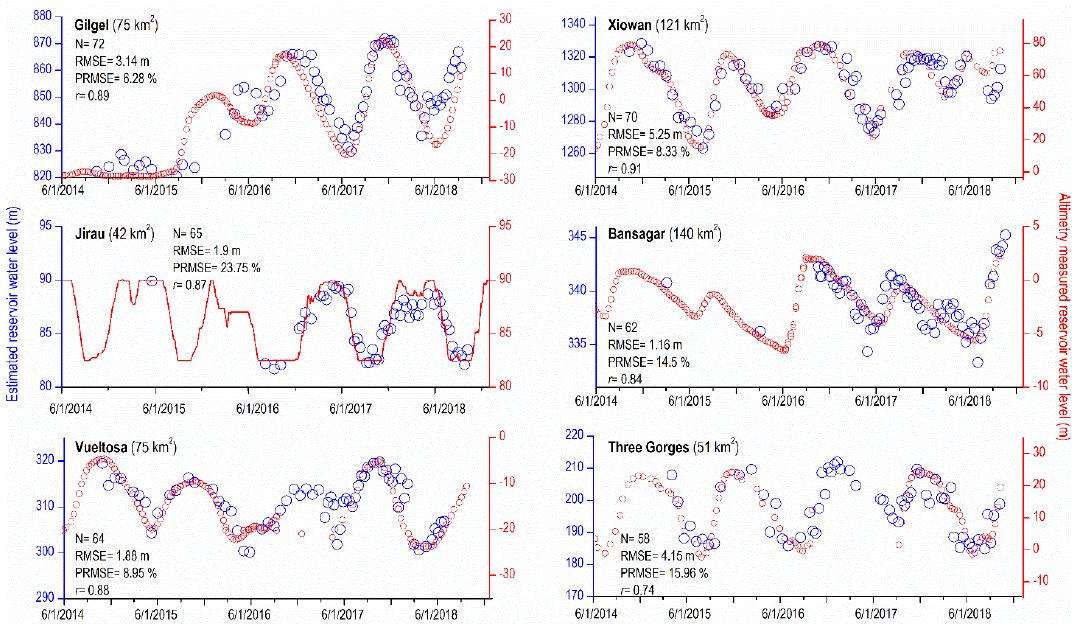
Figure 4. Six reservoir water levels (WL) (June 2014–October 2018) estimated in this study (blue) compared to reference altimetry series (red). Altimetry baseline has been adjusted to match the SRTM baseline. RMSE and percentage RMSE (pRMSE) are provided. In the case of Jirau, in situ WL data from ANA was used for validation.